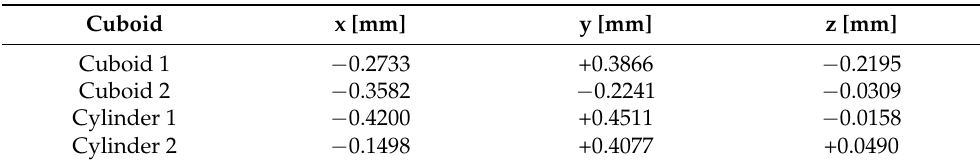
Table 5. Workpiece zero-point deviations of all samples between touch probe and laser object detection with laser